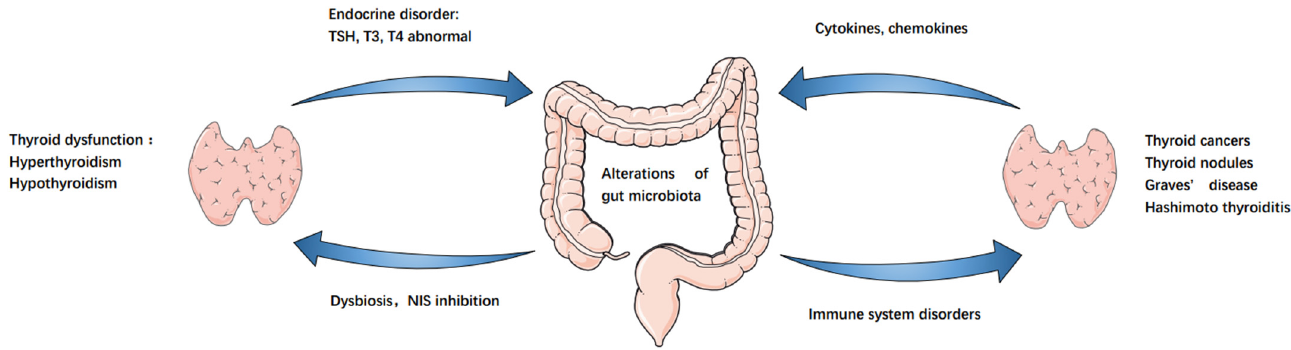
Figure 1. Gut–endocrine–thyroid cancer axis. Alterations of gut microbiota led to NIS inhibition, resulting in decreased thyroid iodine uptake and immune system, resulting in thyroid dysfunction, thyroid autoimmune diseases and thyroid cancer. Similarly, these diseases cause further changes in the gut microbiota.